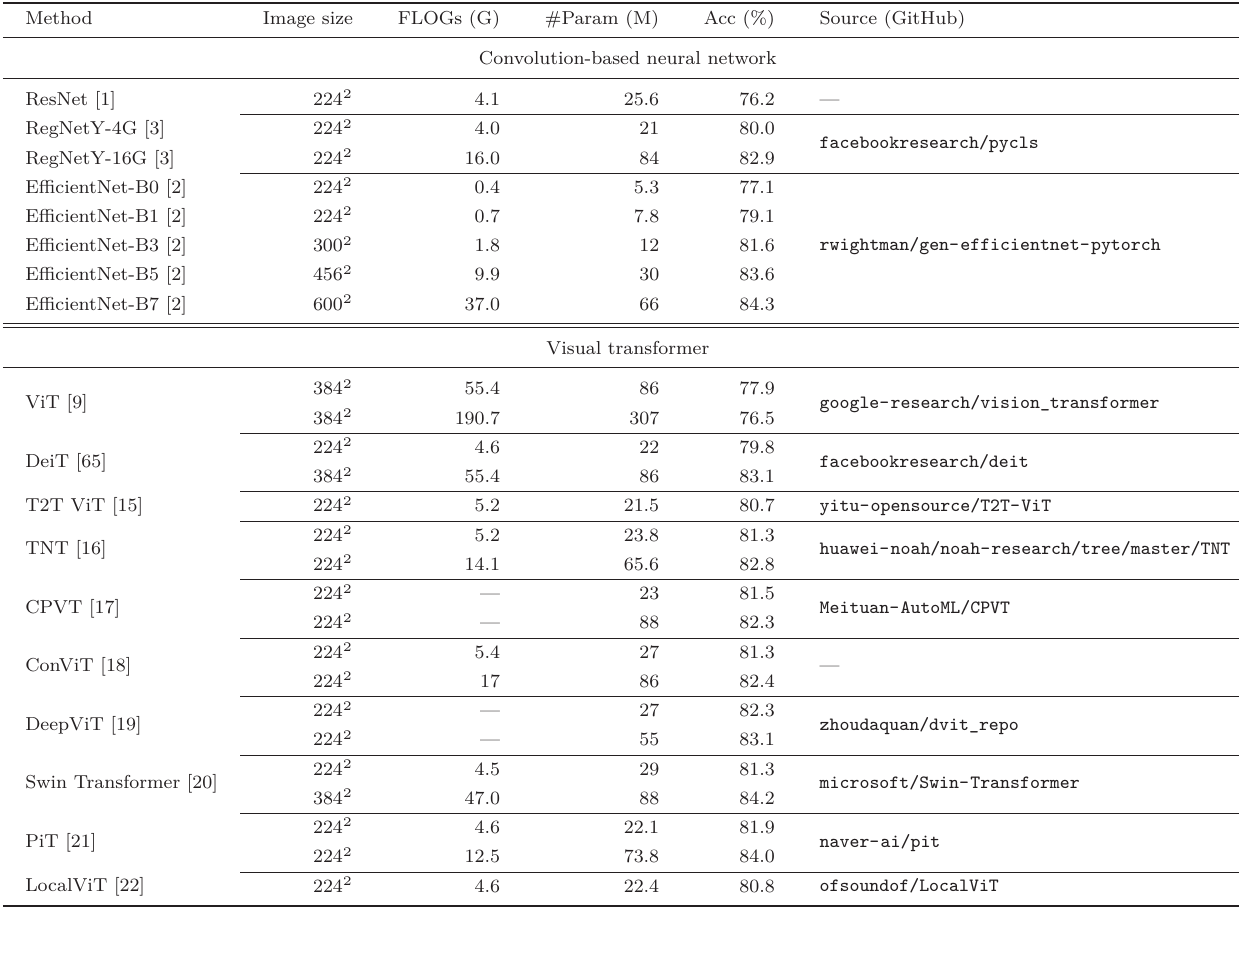
Table 2 Classification accuracy on ImageNet [64] for various visual transformers